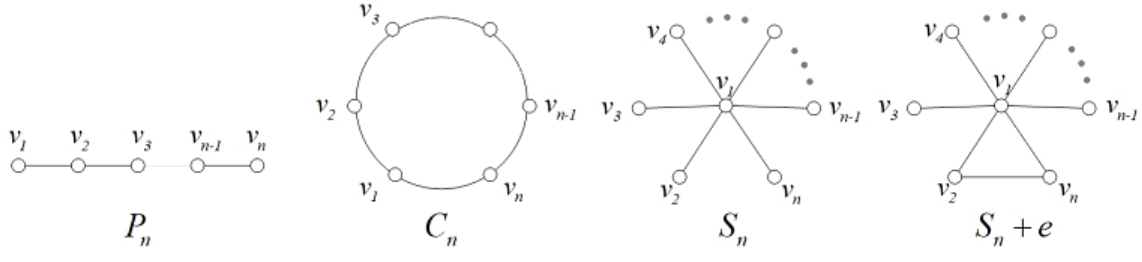
Figure 1: The graphs P n , C n , S n and S n +